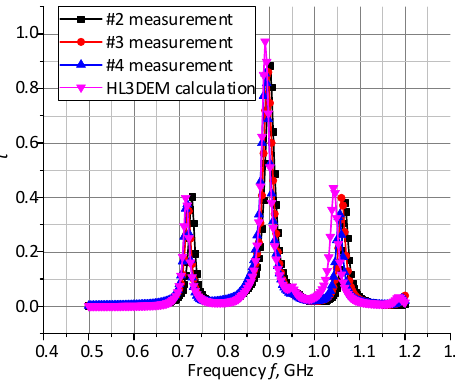
Figure 11. Comparison of measurements and numerical calculations of antenna complex impedance Z TA : ( a ) real part; ( b ) imaginary part.